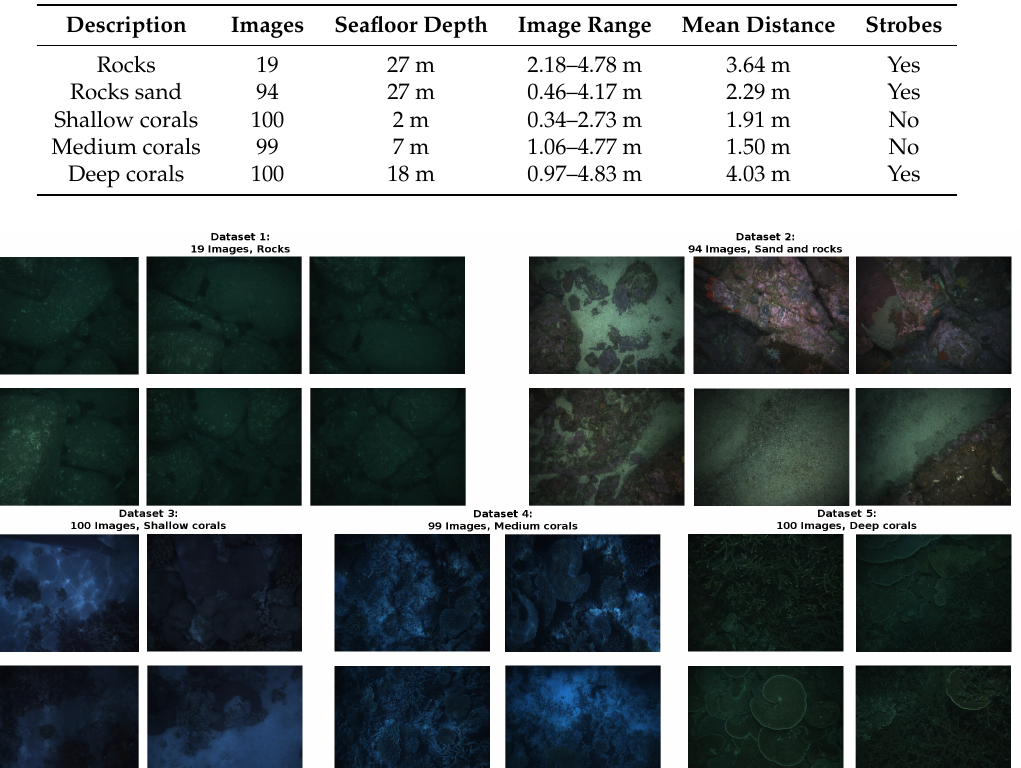
Table 1. Description of datasets.